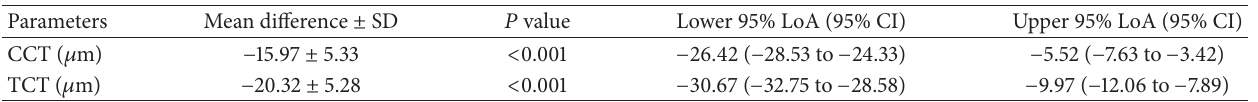
Table 3: Comparison of central corneal thickness (CCT) and the thinnest corneal thickness (TCT) readings by the Scheimpflug-Placido topographic modeling system (TMS-5) and ultrasound pachymetry.